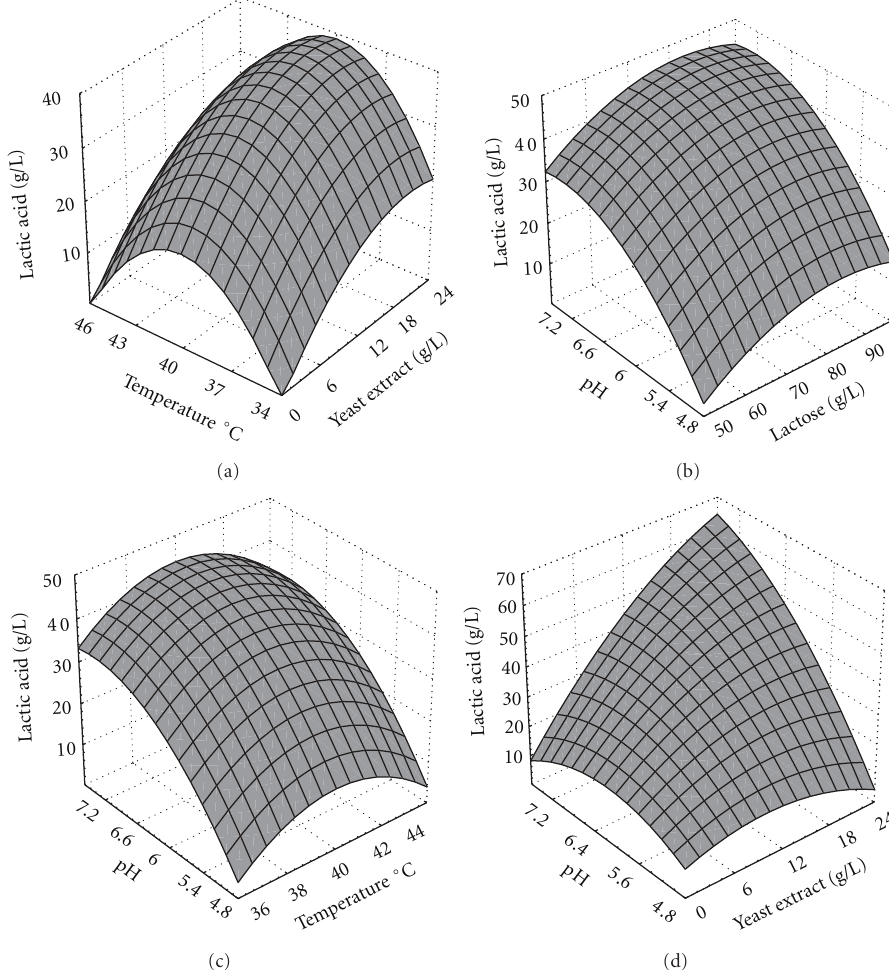
Figure 2: Response surfaces for the production of lactic acid as a function of the variables: (a) temperature and yeast extract concentration; (b) lactose concentration and pH; (c) temperature and pH; (d) yeast extract concentration and pH. For each surface, the other variables are in the center